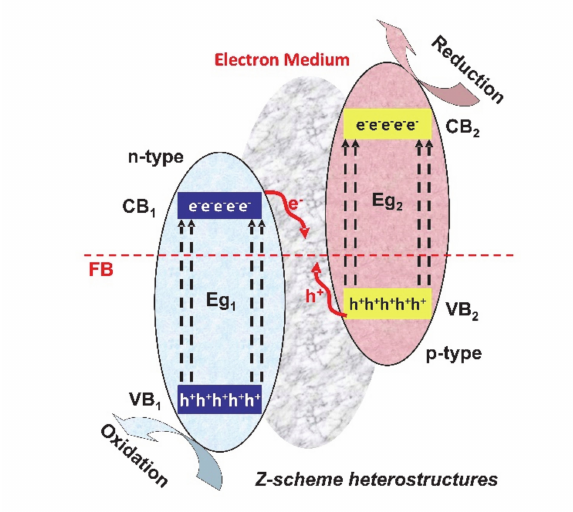
Figure 5. Z-scheme heterostructures for photocatalytic